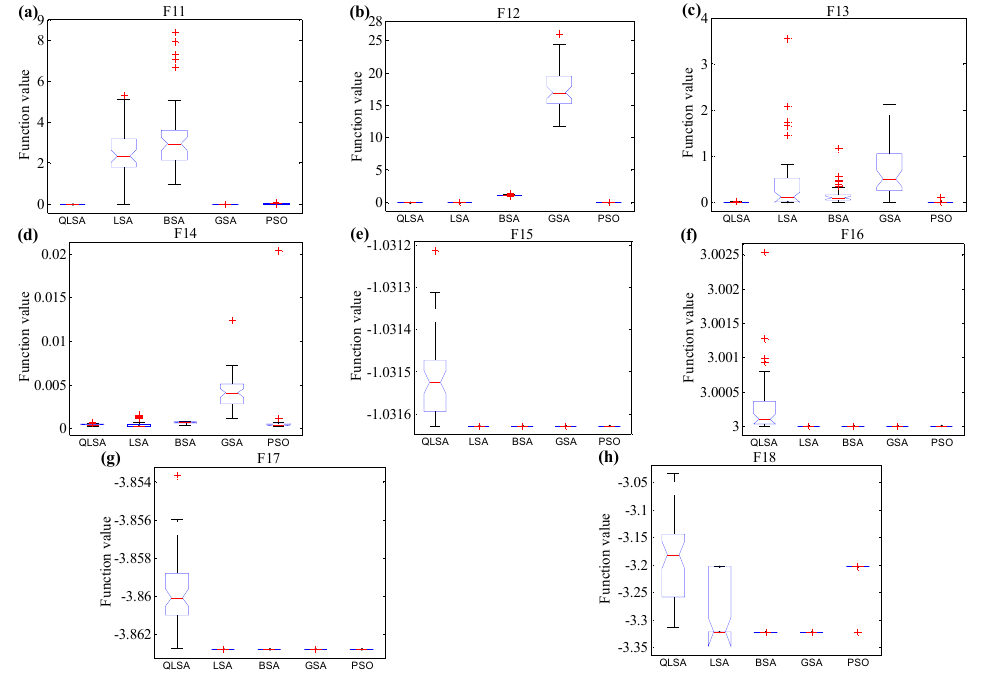
Figure 13. Variation in global optimization results for benchmark functions in Table 6. ( a ) F11; ( b ) F12; ( c ) F13; ( d ) F14; ( e ) F15; ( f ) F16; ( g ) F17; ( h ) F18.